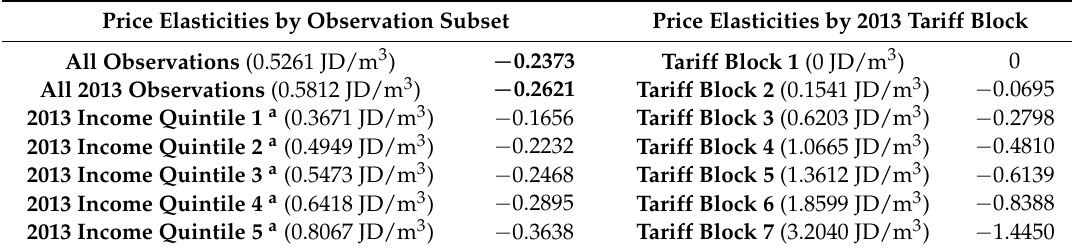
Table 3. Estimates of the price elasticity of household water demand for different subsets of observations, based on the price coefficient from the all-year semi-log